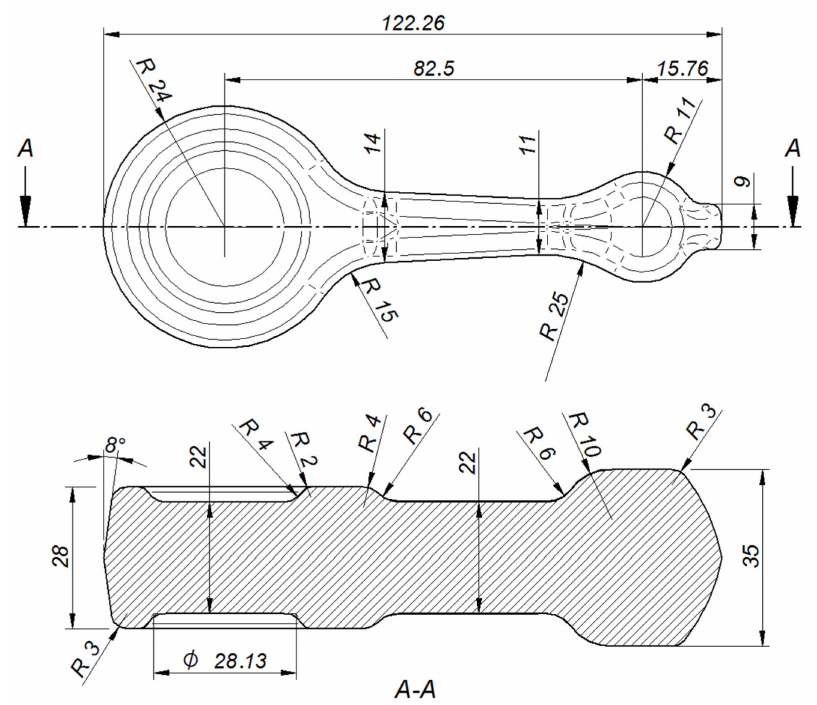
Figure 7. Selected dimensions of the variant 1 preform.